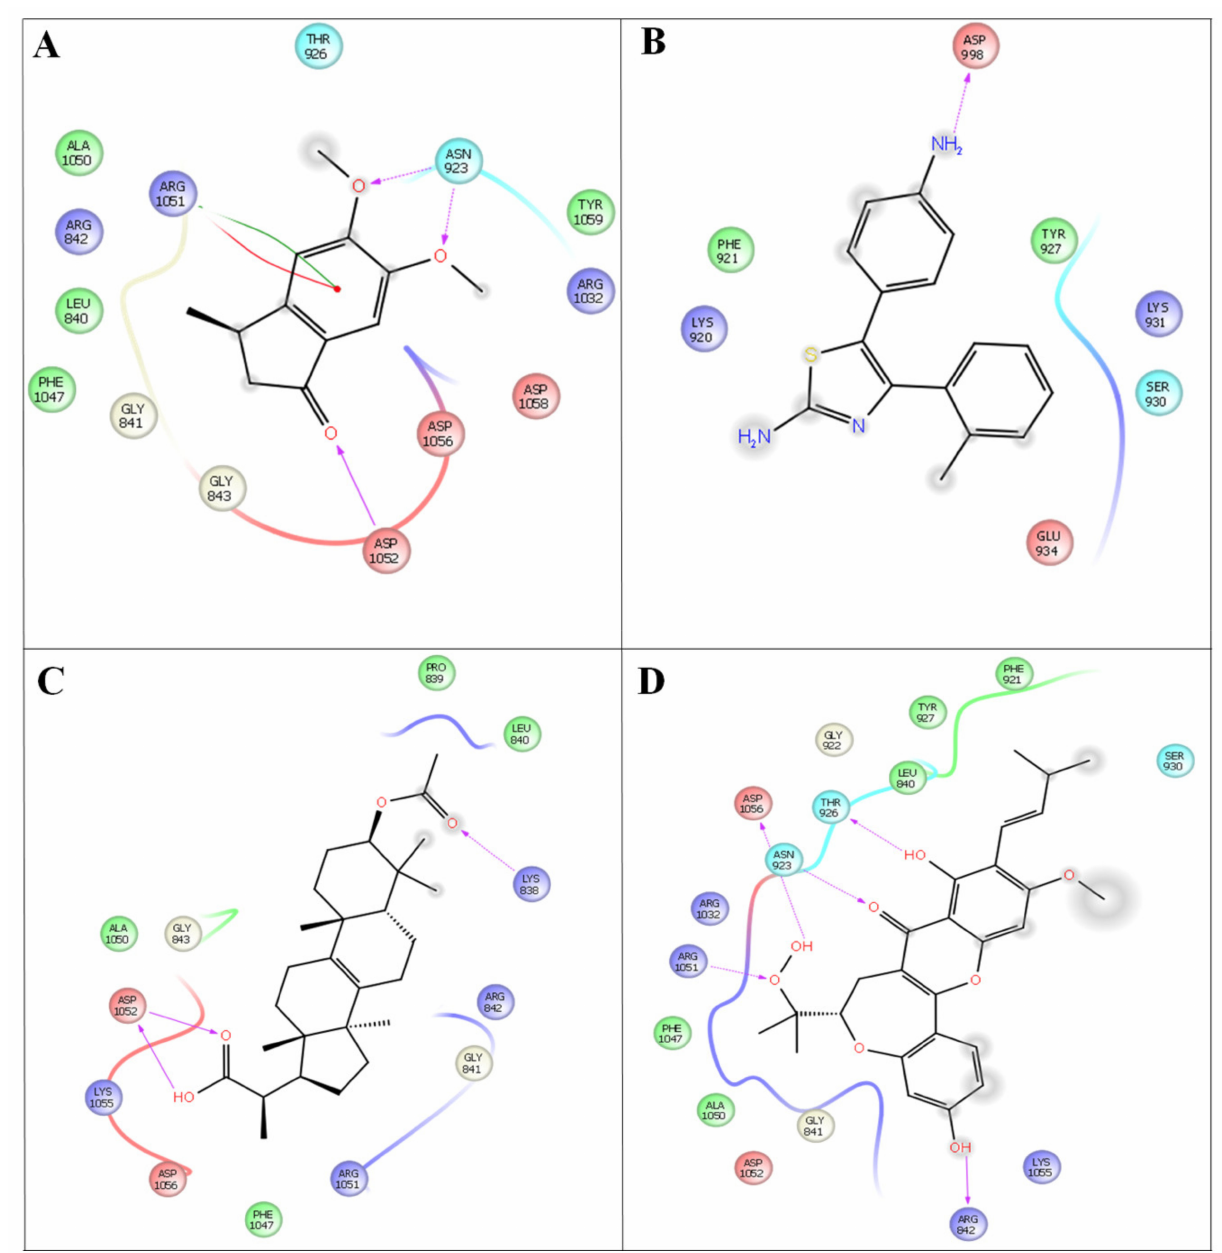
Figure 4. In silico docking studies representing 2 dimentional Azima tetracantha complexes with ligand